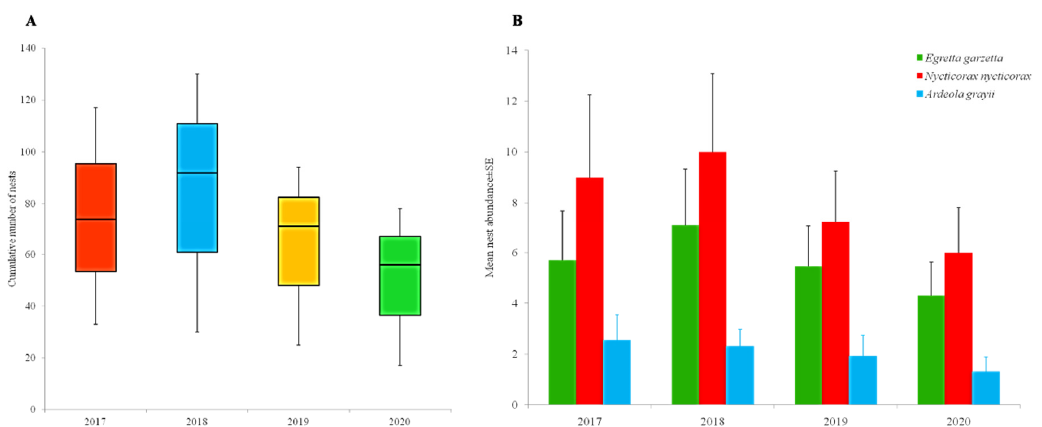
Figure 6. A. Box plots representing year-wise cumulative nest number and B. Histograms representing year-wise mean nest numbers of all three species Nest numbers were recorded for 20 months between 1 May 2017 and 30 September 2020 from 13 tree species. Each box plot represents minimum, lower quartile, median, upper quartile, and maximum values. In both the cases, the mean values were compared using one-way ANOVA with pair-wise comparisons. However, the differences were statistically insignificant (p ˃ 0.05). SE=standard